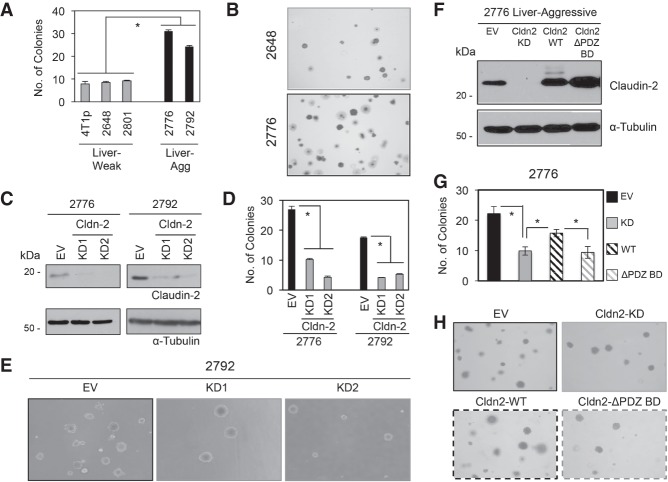
The PDZ-binding motif of Claudin-2 is required for efficient anchorage-independent growth of aggressively liver metastatic 4T1-derived breast cancer cells. (A) Growth of liver-weak (4T1p, 2648, and 2801) and liver-aggressive (2776 and 2792) breast cancer cells in soft agar. (*) P < 0.0001. (B) Representative pictures of colony formation by liver-weak (2648) and liver-aggressive (2776) breast cancer cells are shown. (C) Immunoblot analysis of Claudin-2 expression in liver-aggressive cells (2776 and 2792) infected with independent Claudin-2 shRNA expression vectors (knockdown [KD1 and KD2]) or harboring an empty vector (EV). As a loading control, total cell lysates were blotted for α-Tubulin. (D) Soft agar assays using these breast cancer cells were performed, and colony-forming ability was quantified. (*) P < 0.0001. (E) Representative images of colony formation by liver-aggressive cells with reduced Claudin-2 levels (knockdown [KD1 and KD2]) or control cells (empty vector [EV]) are shown. (F) Immunoblot analysis of Claudin-2 expression in the indicated cell lines. Wild-type Claudin-2 and the Claudin-2 mutant lacking the PDZ-binding motif (Cldn2 ΔPDZ BD) were expressed in 2776 liver-aggressive breast cancer cells lacking endogenous Claudin-2. Pooled populations of individual clones (n = 3) expressing either wild-type Claudin-2 or the Claudin-2 ΔPDZ BD mutant are shown. Immunoblot analysis of α-Tubulin served as a loading control. (G) Colony formation of the indicated cells lines in soft agar was analyzed. (*) P < 0.000004. (H) Representative images of colony growth formation in soft agar are presented for each cell population.